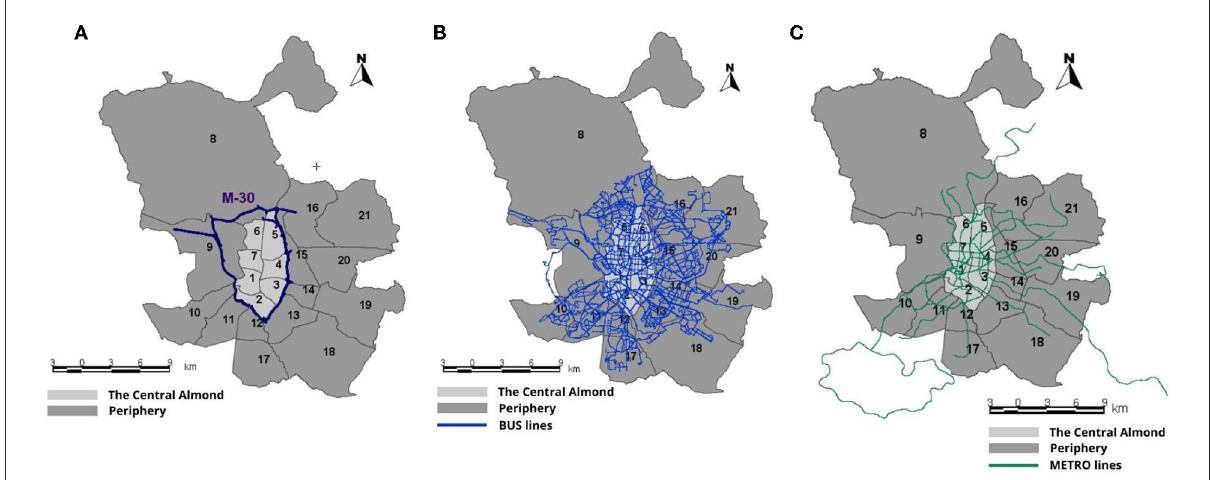
FIGURE1 (A) Transport zones, (B) BUS lines, and (C) METRO lines. Source: Own elaboration. 1-Center; 2-Arganzuela; 3-Retiro; 4-Salamanca; 5-Chamartín; 6-Tetuán; 7-Chamberí; 8-Fuencarral-El Pardo; 9-Moncloa-Aravaca; 10-Latina; 11-Carabanchel; 12-Usera; 13-Puente de Vallecas; 14-Moratalaz; 15-Ciudad Lineal; 16-Hortaleza; 17-Villaverde; 18-Villa de Vallecas; 19-Vicálvaro; 20-San Blas-Canillejas;